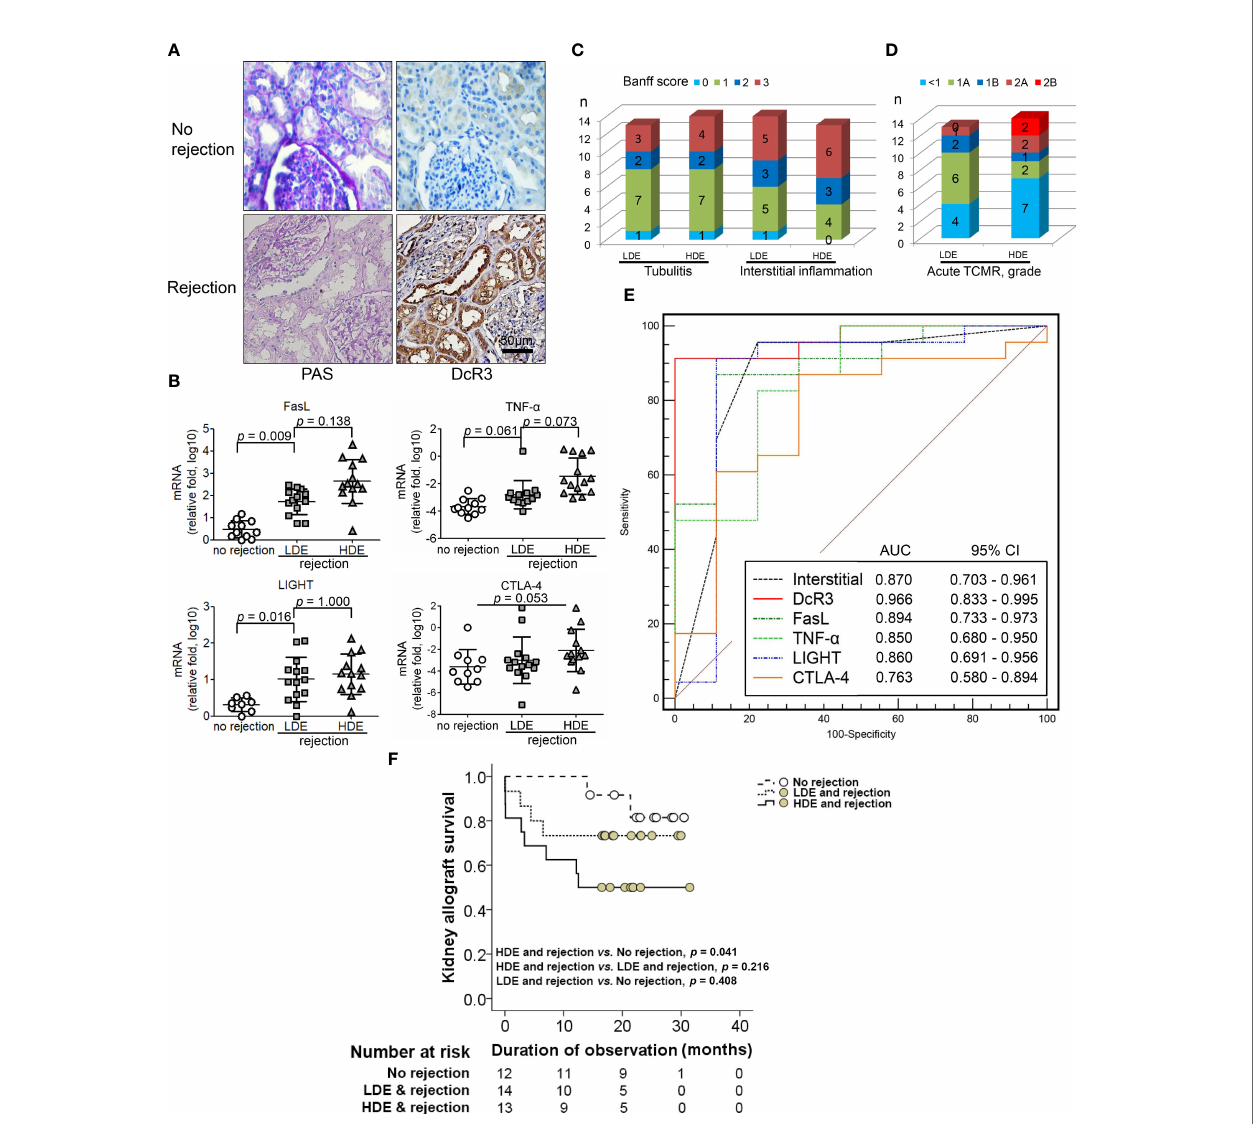
FIGURE 7 | Correlation of decoy receptor 3 (DcR3) molecule with acute T-cell-mediated rejection. (A) Periodic acid – Schiff and DcR3 immunohistochemical staining of recipients without and with rejection. (B) Apoptosis, in fl ammatory, Teff, and Treg gene expression were correlated with no rejection, low DcR3 expression (LDE), and high DcR3 expression (HDE). (C) HDE was associated with Banff tubulitis, interstitial in fl ammation, and (D) TCMR grading severity ( n = 27). (E) Predictive value of DcR3 gene expression in recipients with acute TCMR after comparison with pathological fi ndings and TNF ligand and receptor-related gene expression in humans with biopsy-proven acute cellular rejection. (F) Survival curves in renal transplant recipients with no rejection and rejection with high and low DcR3 expression. Kaplan – Meier cumulative curves for composite endpoints: serum creatinine doubling or graft failure. HDE, high DcR3 expression; LDE, low DcR3 expression; HDE and LDE were determined by the median qPCR values of human kidney transplant biopsy